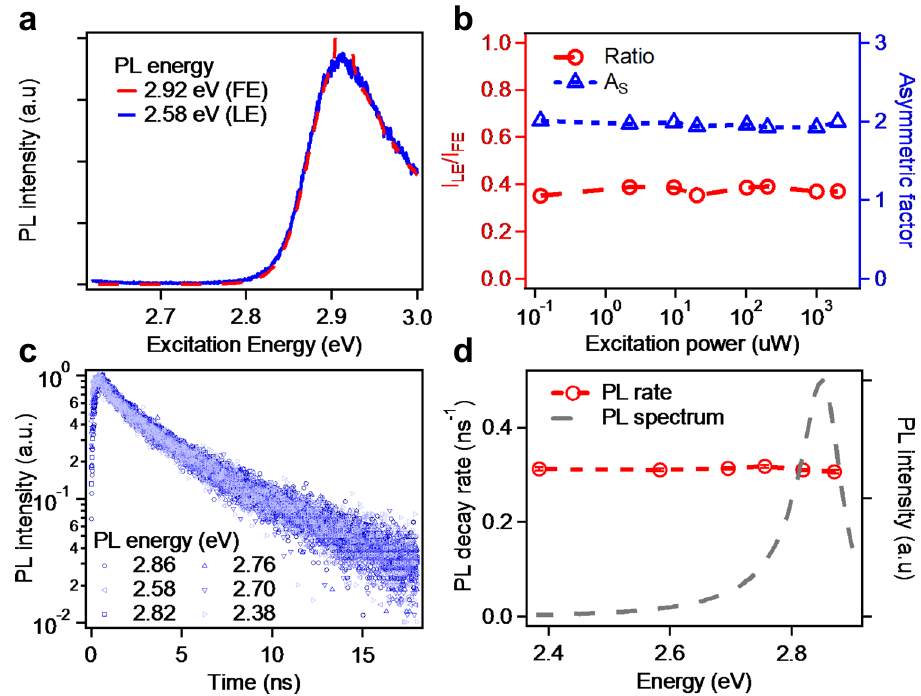
Fig. 2 Equilibrium of FE and LE emission at room temperature. a PLE spectra of 2L CsPbBr 3 NPs monitored at FE emission (2.92 eV) and LE emission (2.58 eV). b LE ratio and asymmetric factor as a function of excitation power. c PL decay kinetics and d PL decay rate at different energies (2.38 – 2.86